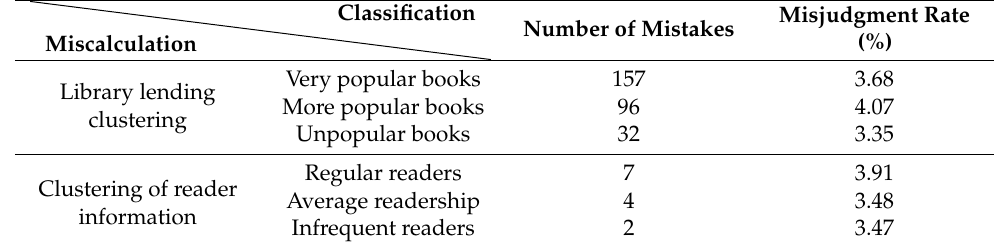
Figure 8. Data misjudgment result diagram. Table 3. Data misjudgment result